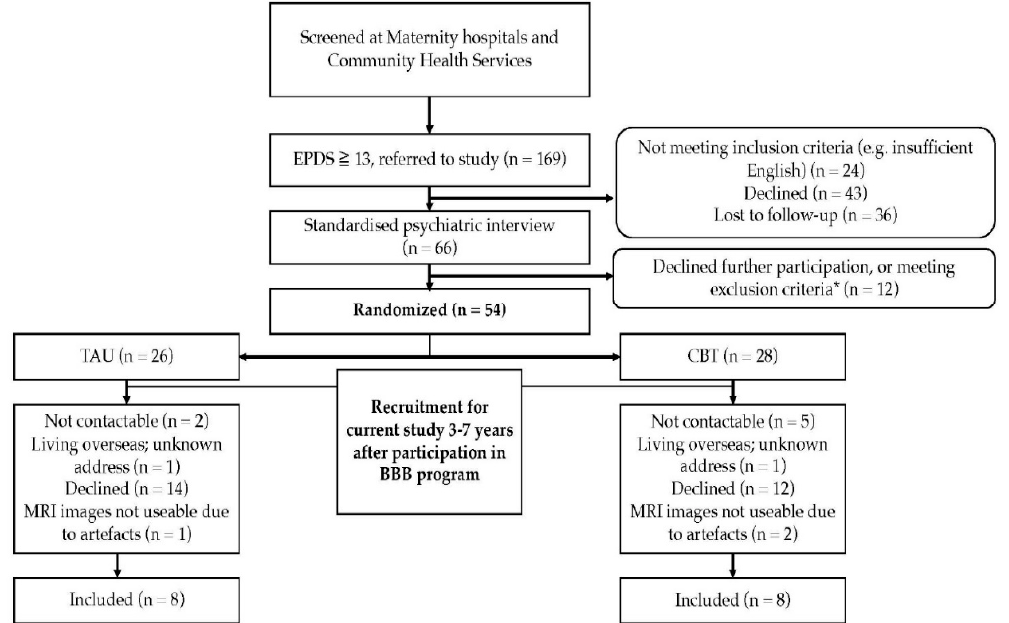
Figure 1. Flow diagram of participant recruitment. * Not meeting the inclusion criteria, comorbid axis I disorders, medical conditions at risk for interference with study participation, concurrent major psychiatric disorders for which the intervention was not designed (e.g., bipolar and psychotic disorder), risk requiring crisis management, current participation in other psychological programs, or significant difficulty with English.